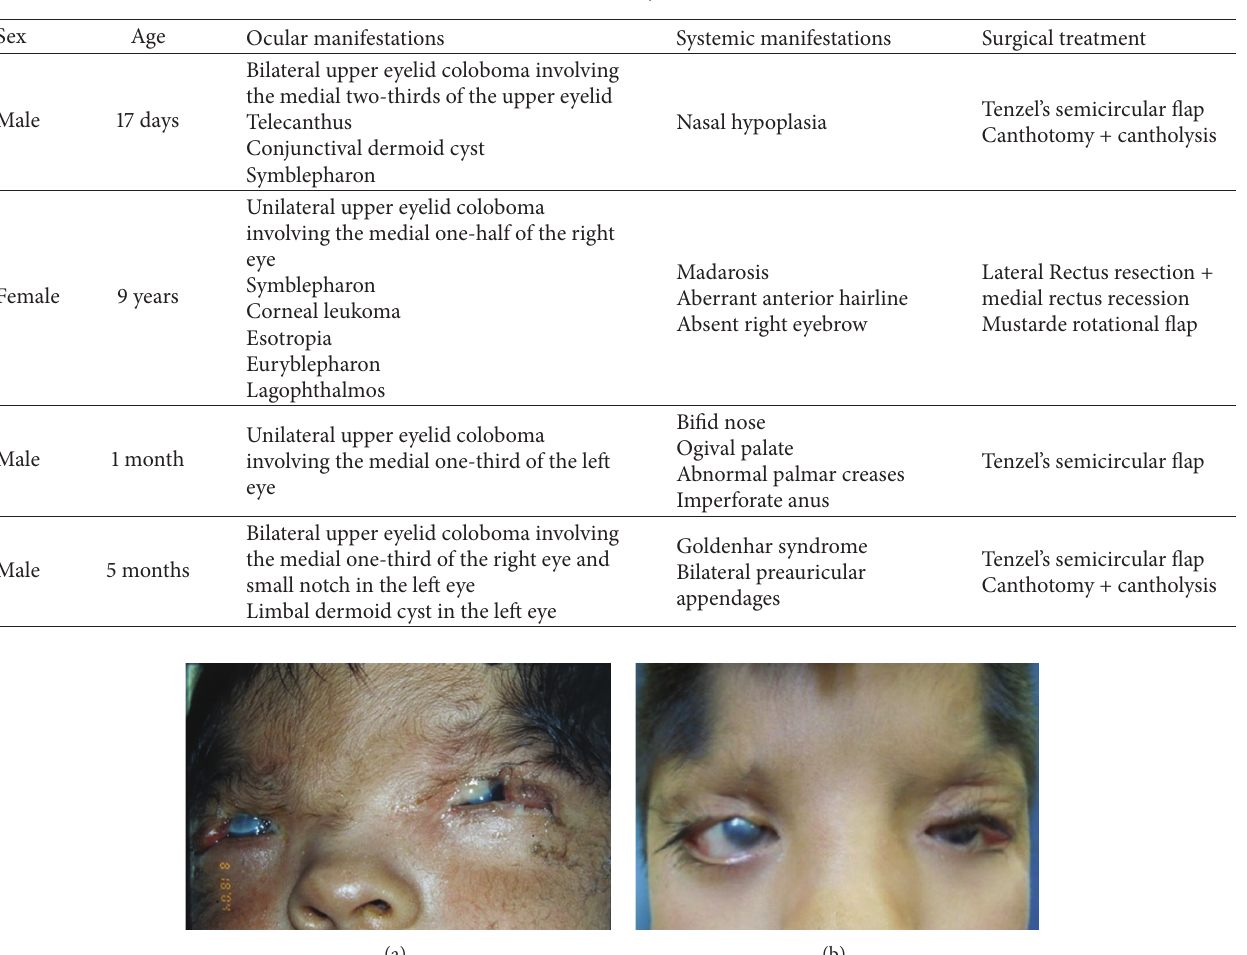
Table 1: Summary of cases.